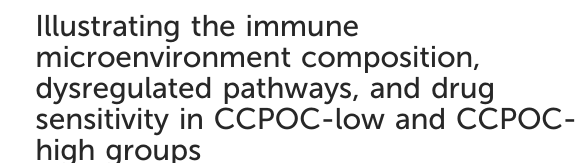
Illustrating the immune microenvironment composition,